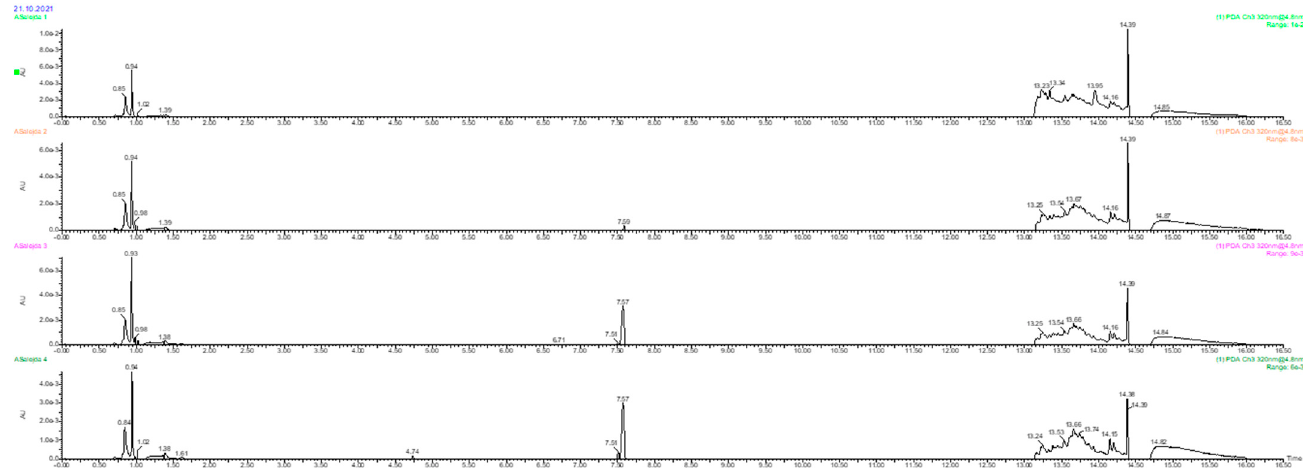
Figure 4. Comparison of representative UPLC-MS chromatogram of studied sausages.